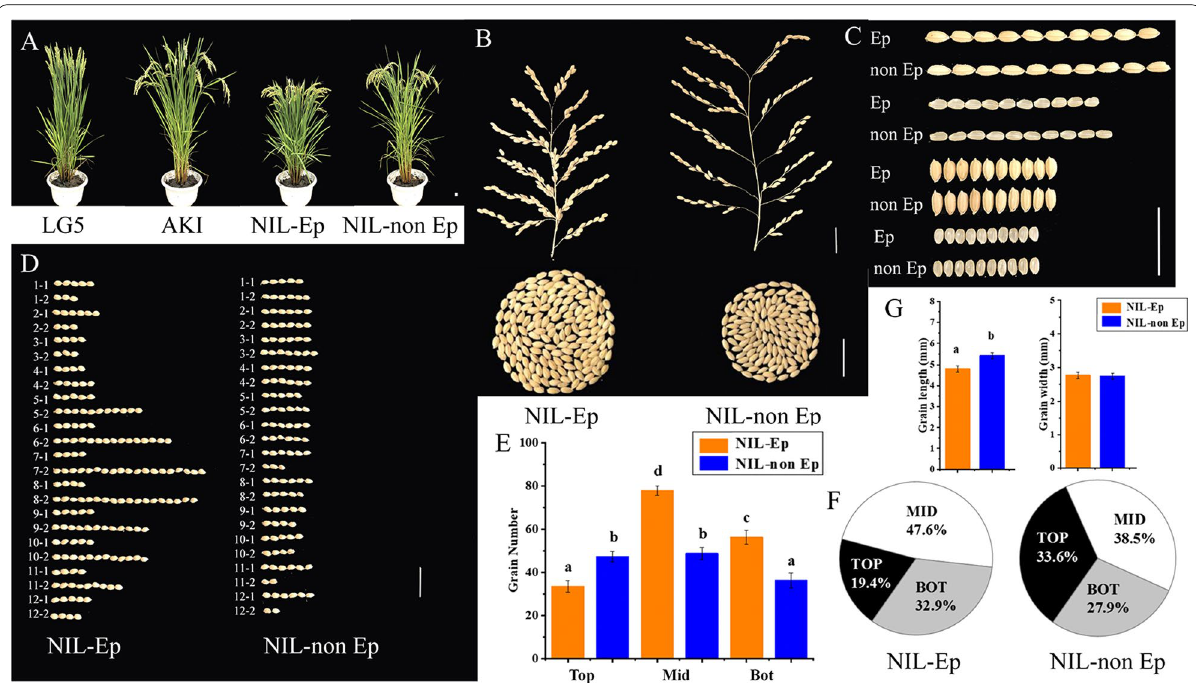
Fig. 2 The yield performance and grain shape of NIL-Ep and NIL-non Ep plants. A The four experimental materials plant in pot under high nitrogen treatment. B The panicles and grain numbers per panicle of the NIL-Ep and NIL non Ep. C The grain size of the NIL-Ep and NIL non Ep. D The grain numbers of different panicle locations for NIL-Ep and NIL non Ep, divided rice panicles into 24 positions from 1–1 to 12–2 according to the origin positions of branches. e.g. 1–1 represented primary branches at the top and 12–2 represented the secondary branches at the bottom. E Difference analysis of grain number in different panicle parts, the panicle is divided into 3 parts namely top (top, from 1–1 to 4–2 panicle positons), middle (mid, from 5–1 to 8–2 panicle positons) and bottom (bot, from 9–1 to 12–2 panicle positons) respectively. F Proportion of grain number in different panicle positions. G Difference analysis of grain shape. (a), (b) Significance at the 0.05 level. Scale bar, 2